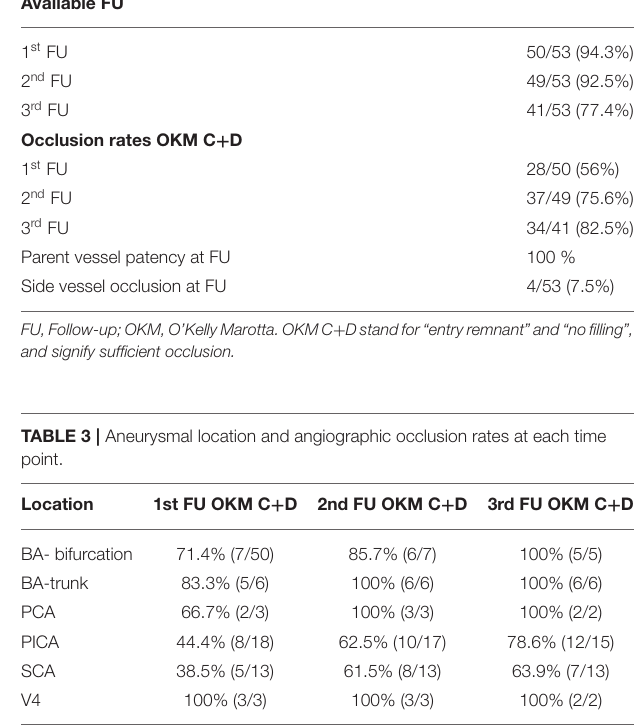
TABLE 2 | Angiographic results and occlusion rates. Available FU